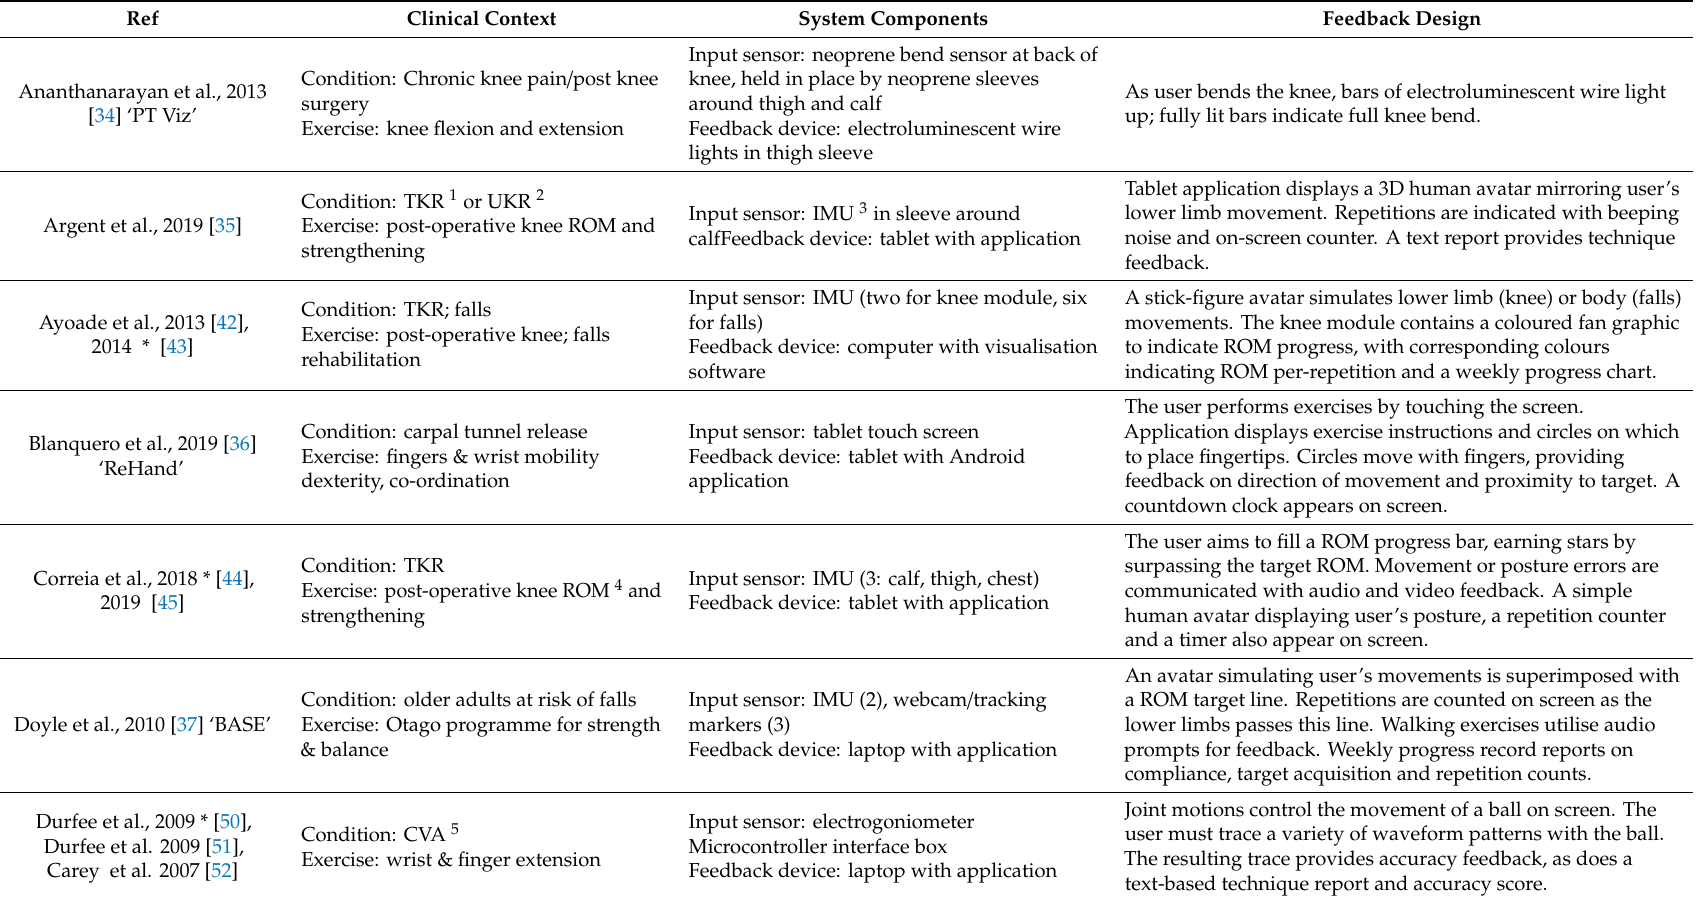
Table 2. Characteristics of the